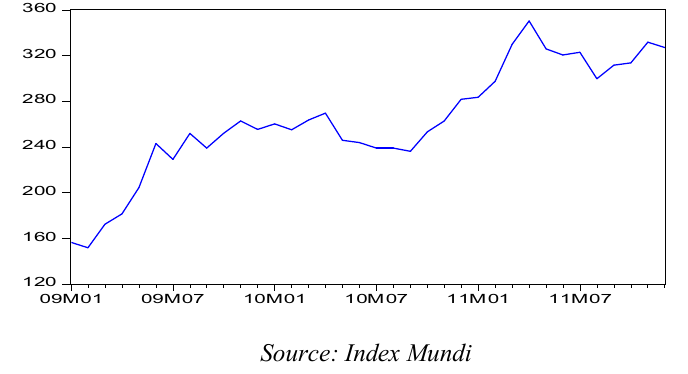
Figure 2: Oil Price in Malaysia From january, 2009 to December,